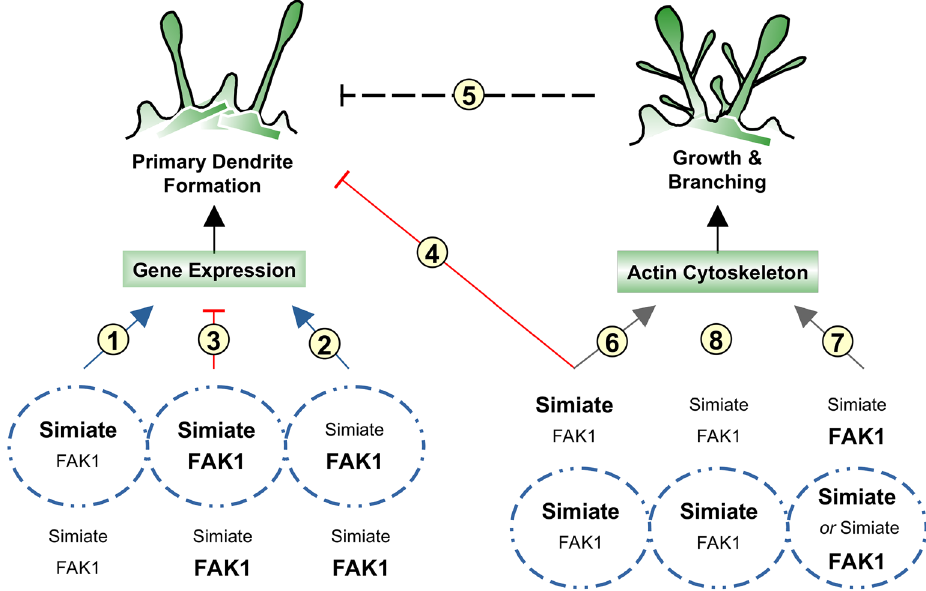
Figure 14. A model illustrating functions of FAK1 and Simiate in dendritogenesis based on our data. The picture depicts the putative molecular mechanisms underlying FAK1 and Simiate regulated dendritogenesis. Dotted circles represent nuclei, the surrounding area somata and dendrites. For both compartments, the expression levels of FAK1 and Simiate are indicated with either bold letters, representing enhanced expression, or regular letters, representing natural expression levels. (1) Nuclear Simiate influences gene expression and triggers primary dendrite formation. Based on our developmental data, this might occur around div 1,